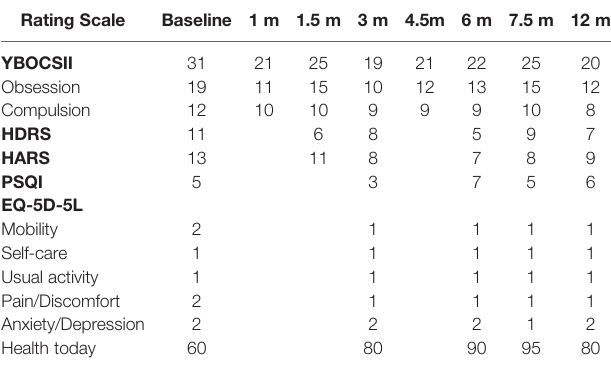
TABLE 3 | Clinical assessment before and after deep brain stimulation